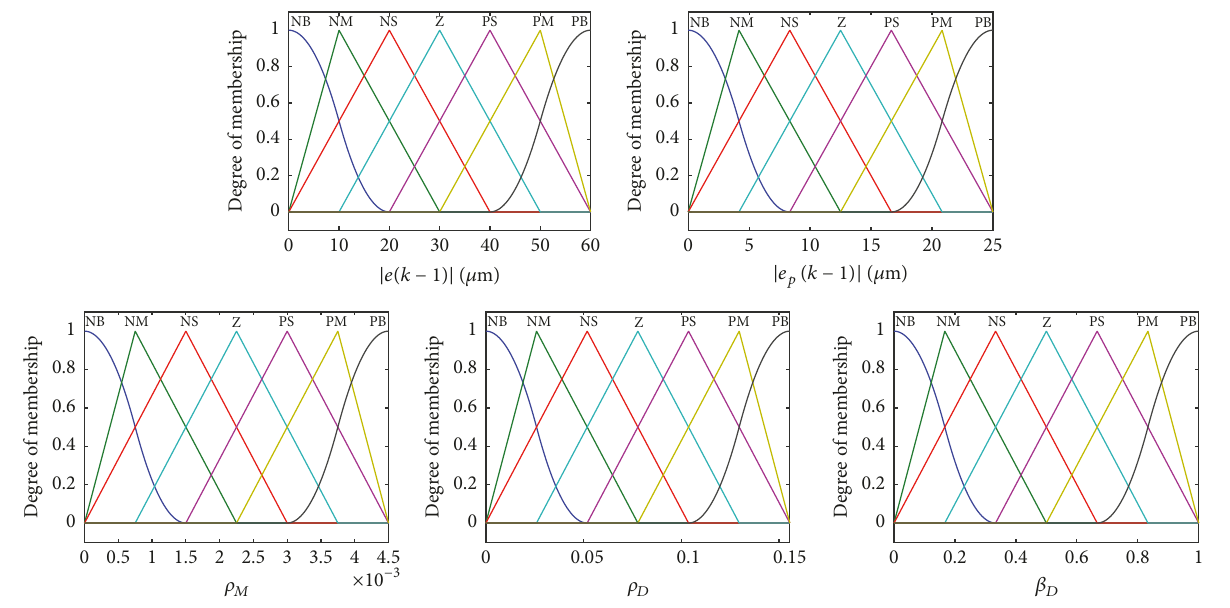
Figure 6: The membership functions of FDDMFAC when 𝑦 0 = 60 .